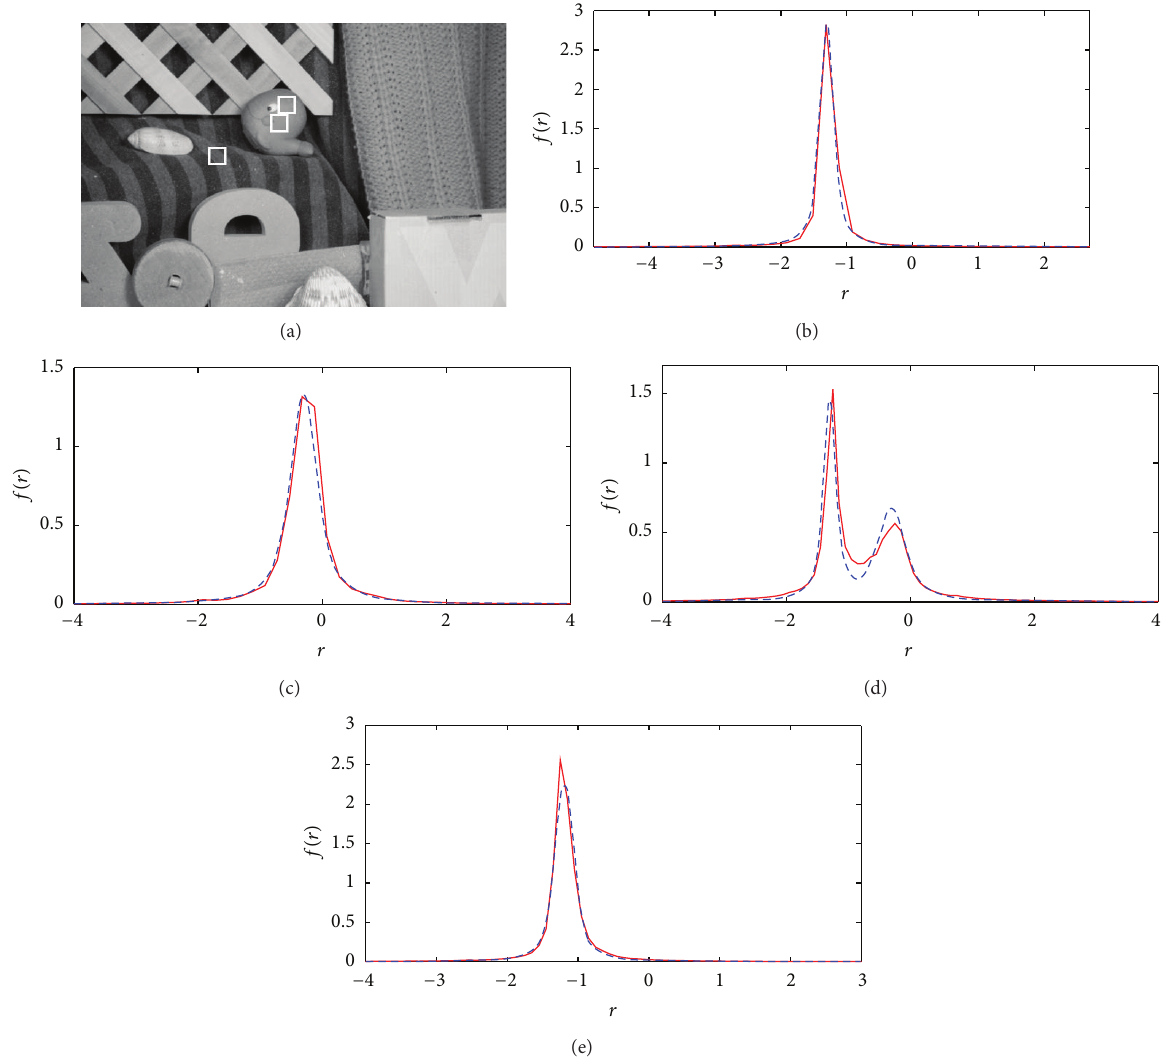
Figure 14: (a) A sample frame of the RubberWhale image sequence. (b) and (c) Theoretical (dashed) and measured (solid) pdf of 𝑟 for two different patches on two different objects highlighted by white rectangles on the sample frame. (d) and (e) Joint pdf of 𝑟 values for two patches: (d) of two different objects and (e) of the same object.